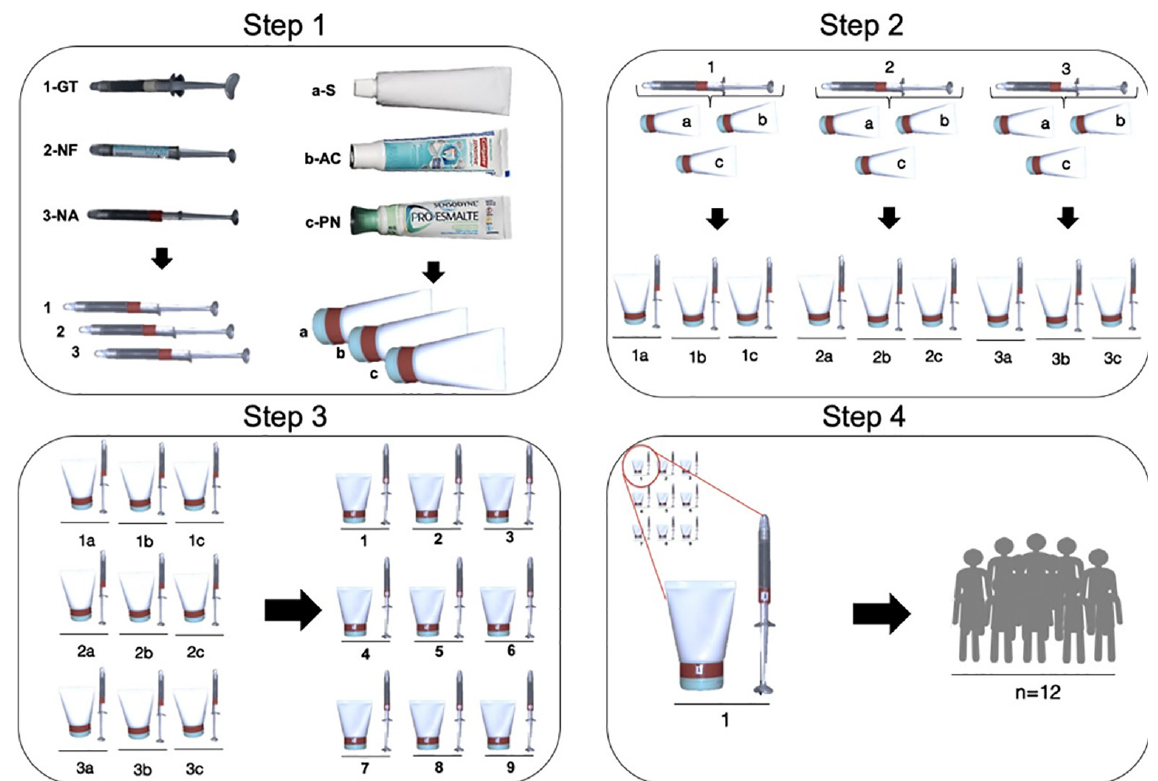
Figure 3- Randomization of the